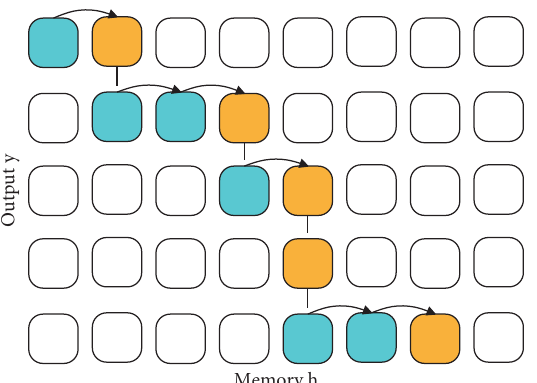
Figure 6: Monotonically increasing attention mechanism.